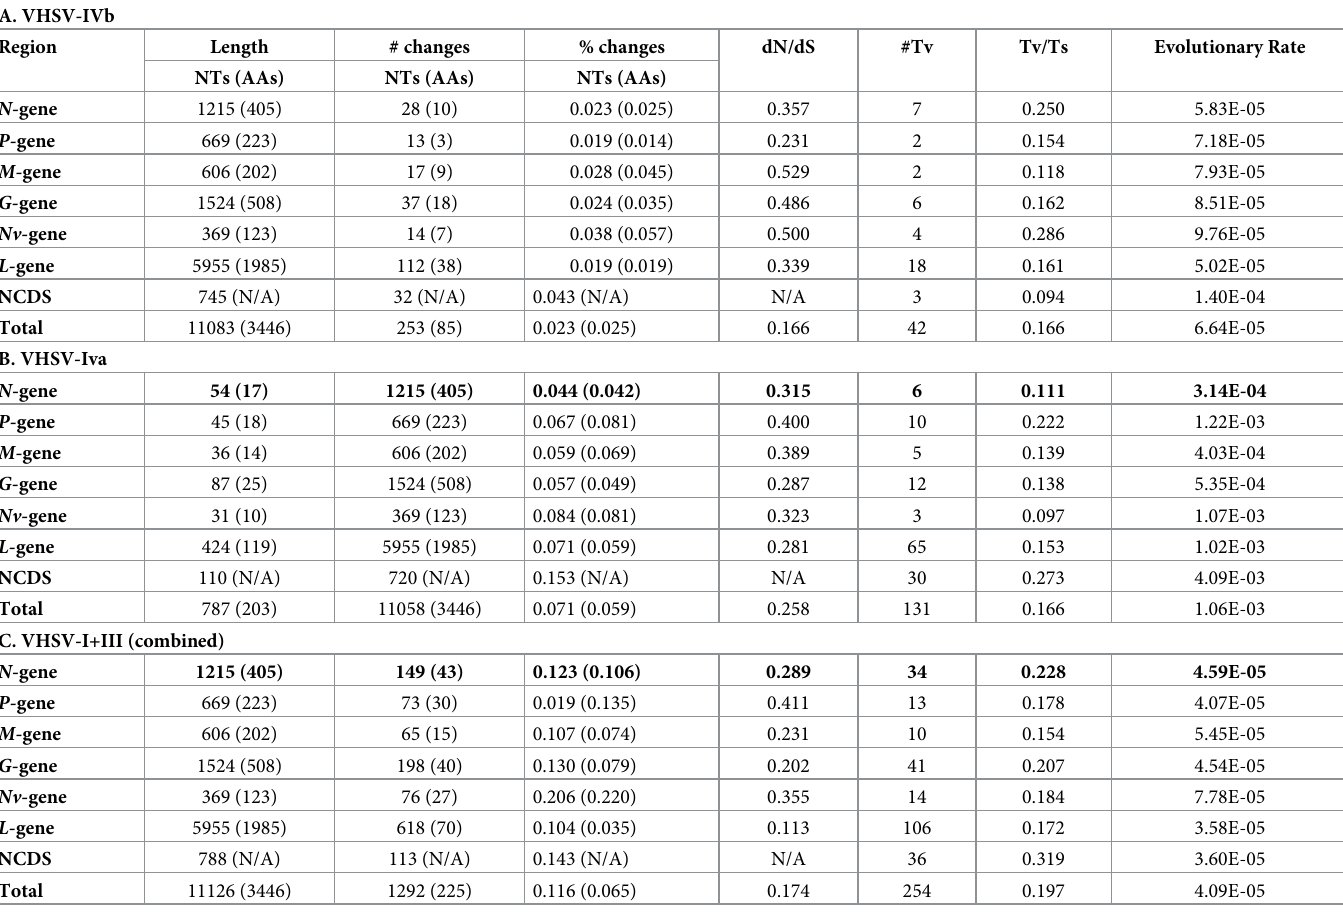
Table 1. Single nucleotide polymorphisms (SNPs) from each gene’s coding region and the combined non-coding regions (NCDS) for VHSV whole genome sequence variants of (A) VHSV-IVb, (B) VHSV-IVa, and (C) VHSV-I+III (combined). A.